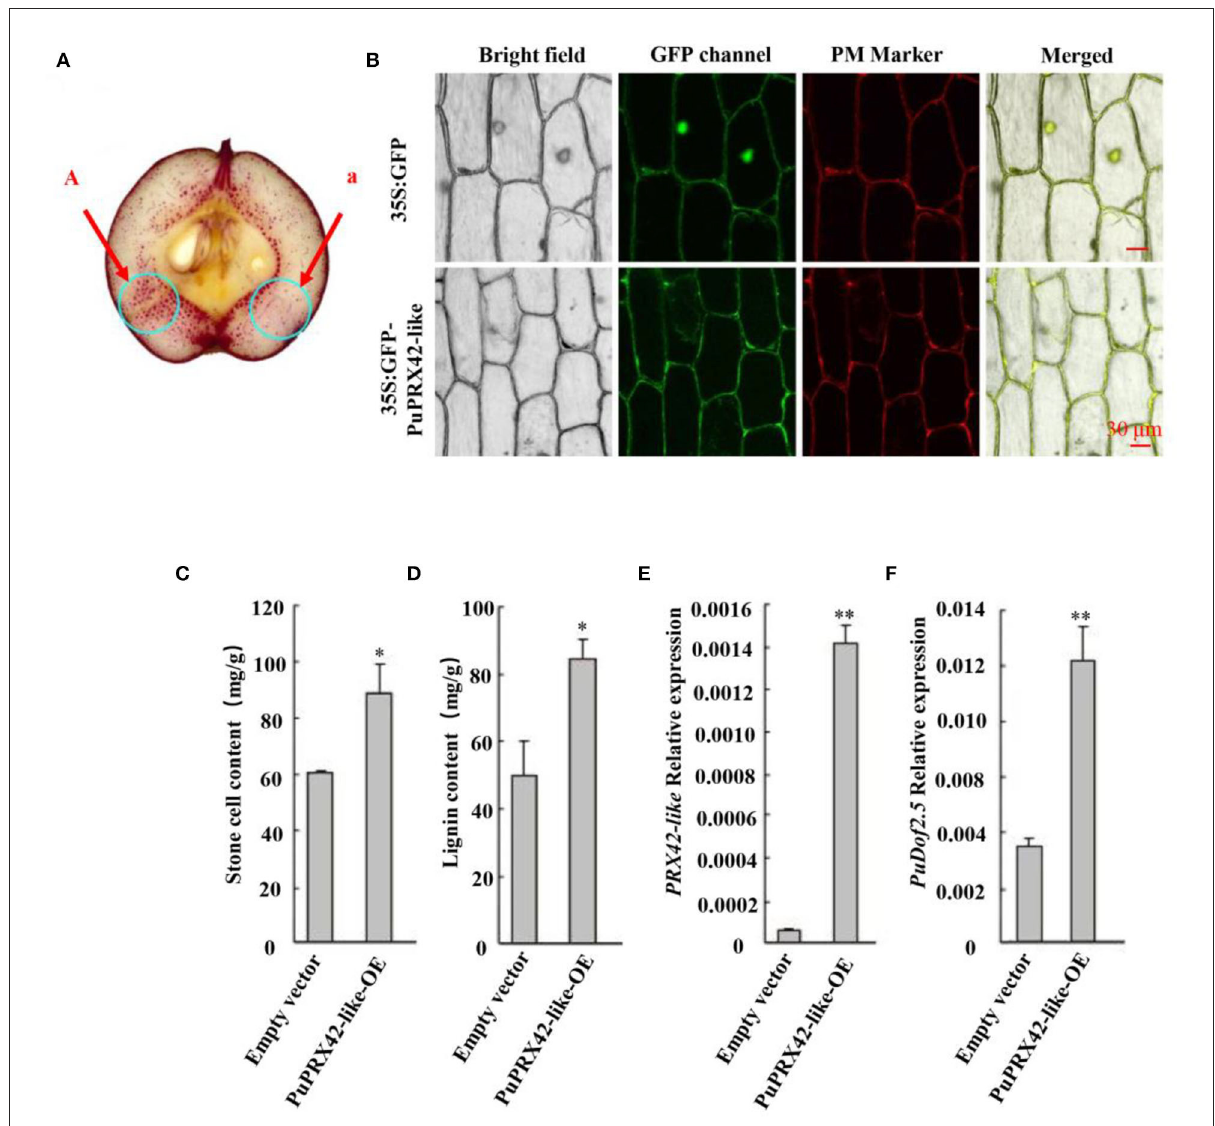
FIGURE3 Functional analysis of PuPRX42-like . PuPRX42-like was transiently expressed in pear fruits (PuPRX42-like-OE) 30 DAFB following Agrobacterium -mediated transient transformation, The transformed pear fruits were harvested 7 days after infiltration to be analyzed by (A) staining the sections with phloroglucinol-HCl (A, pRI101-PuPRX42-like; a, pRI101). (B) Subcellular localization of PuPRX42-like was determined by transiently overexpressing PuPRX42-like , 35Spro ::GFP, and 35Spro :: PuPRX42-like -GFP constructs in onion bulb cells; PM marker served as a membrane marker (scale bar 30 µ m). (C) Stone cell production and (D) lignin content were measured. (E) PuPRX42-like and (F) PuDof2.5 expression levels in PuPRX42-like-OE fruits were determined by qRT-PCR. Data are shown as mean ± SE (n = 3). Statistical significance